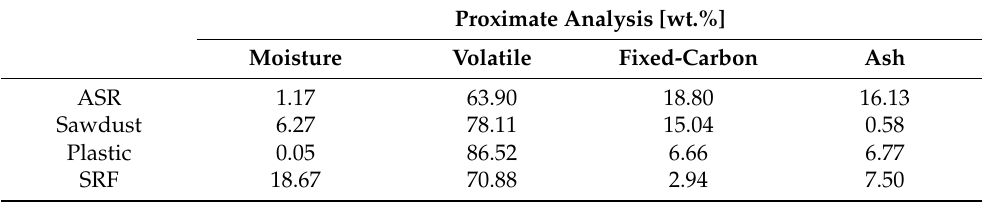
Table 8. Proximate Analysis Result on Each